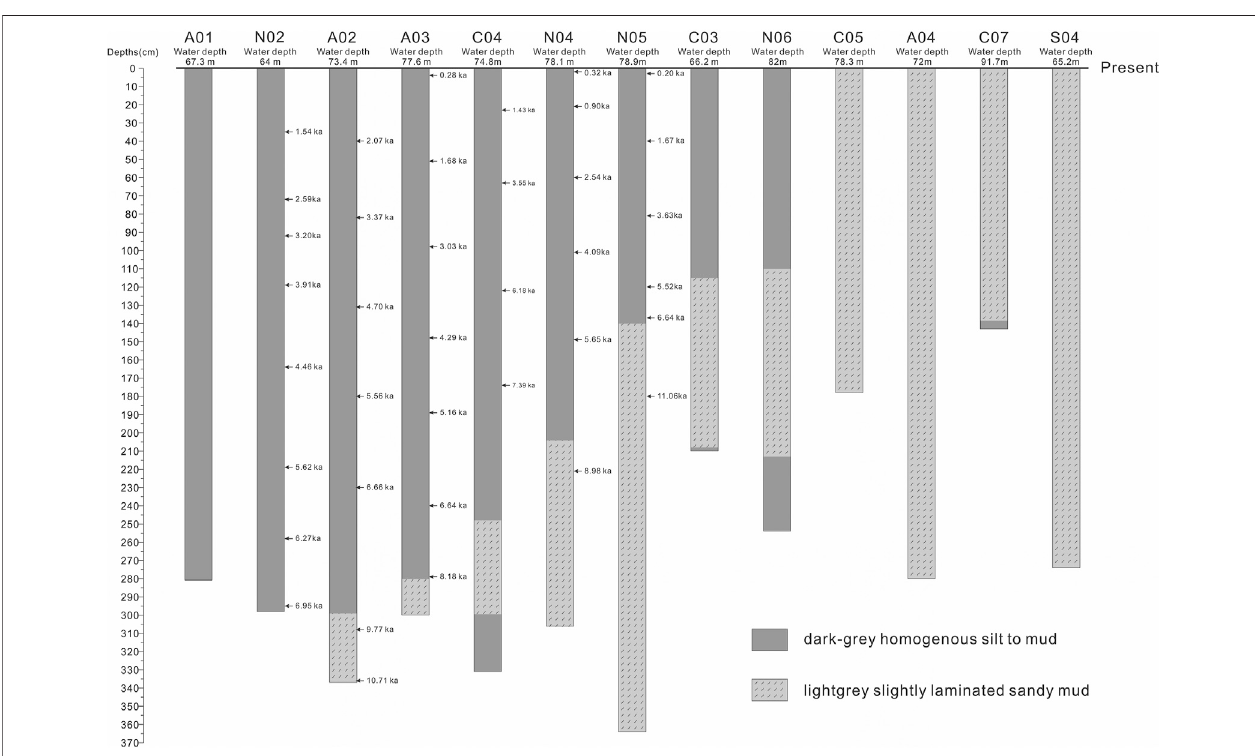
FIGURE 2 | Sediment cores retrieved from the CYSM zone in April 2011. The age models of cores N02, A02, and A03 have already been published (Zhong et al., 2018;Jiaetal.,2019;Wuetal.,2019).SedimentcoresA01,A04,C03,C04,C05,C07,N04,N05,N06,andS04were fi rstusedinthisstudy;coresA01,N04,N05,C04 are well-dated ( Table 2